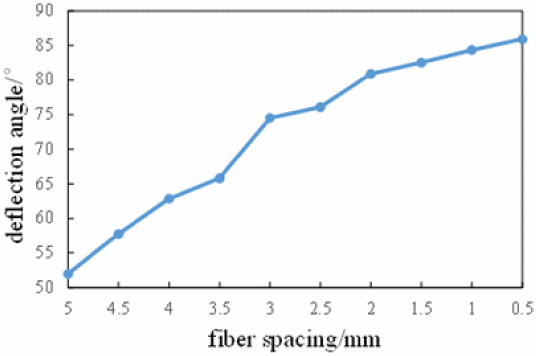
Figure 5. Relationship between fiber spacing and deflection